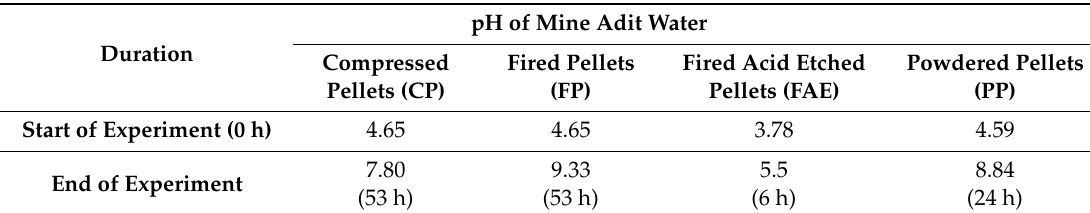
Table 1. PH changes in the mine adit water using the different types of pellet. Raw data extracted from Turner (2017) [21] and Hill (2016) [19].